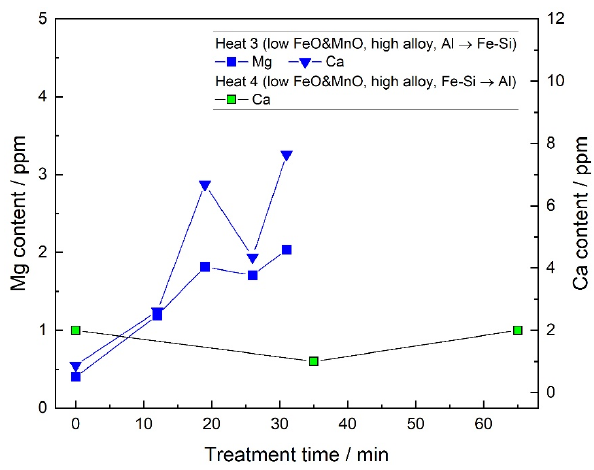
Figure 9. Comparison on the Ca and Mg contents between heat 3 and heat